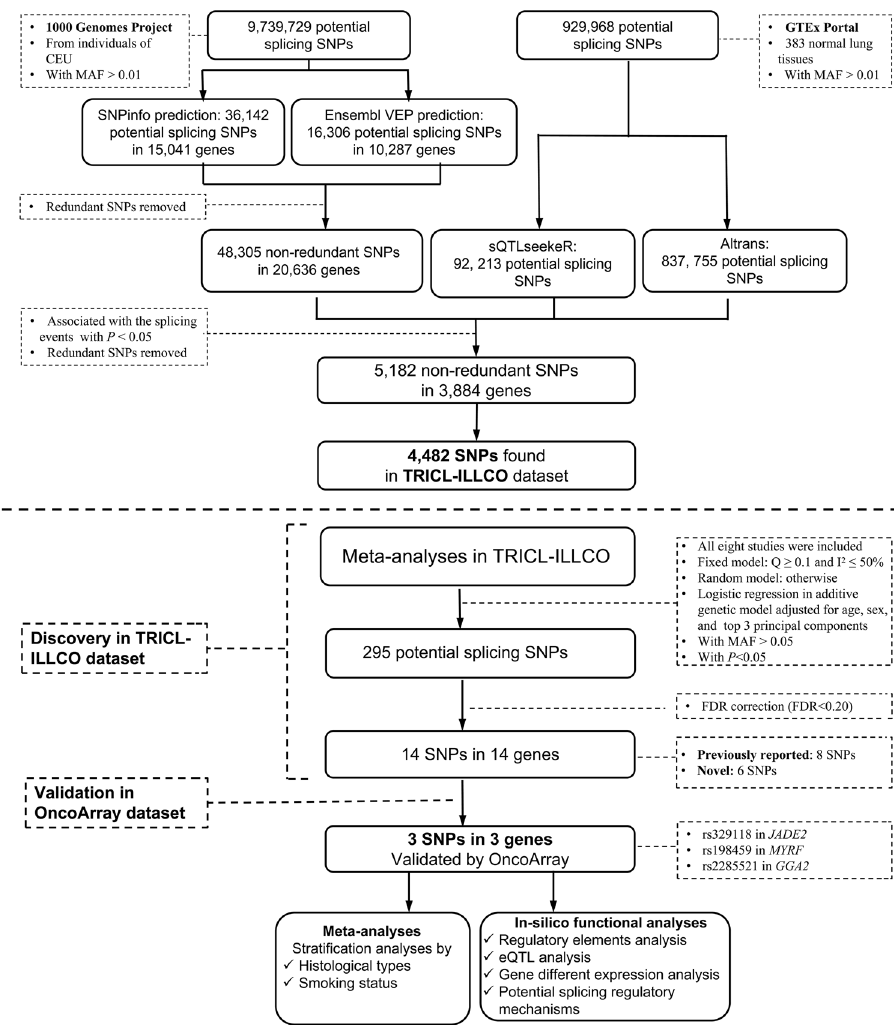
Fig. 1 Study fl owchart. CEU Caucasian, MAF minor allele frequency, FDR false discovery rate, eQTL expression quantitative trait